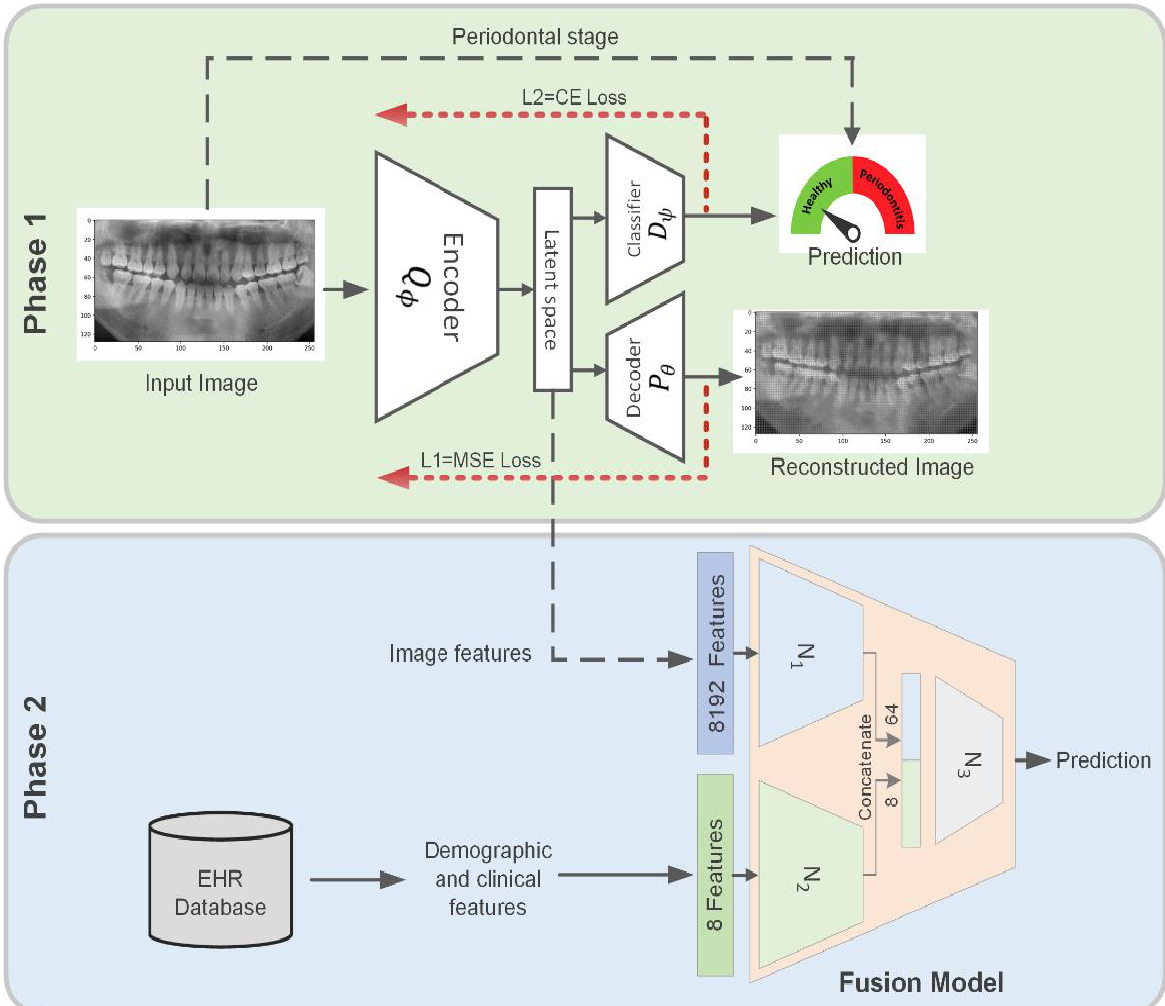
Figure 1. The overall schema of the model. Phase 1: We used the raw OPG images as input to an autoencoder to extract periodontal disease-related features. The autoencoder has a dual-loss architecture, with mean squared error (MSE) and cross-entropy (CE) losses. After training the autoencoder, the latent space of the model is used for the next step. Phase 2: The periodontal disease-related features (the latent space of the autoencoder) have been used as inputs in a deep neural network model. The patient demographic data extracted from the EHR were combined with the image features to train the model. Prediction of systemic diseases using the fusion model.